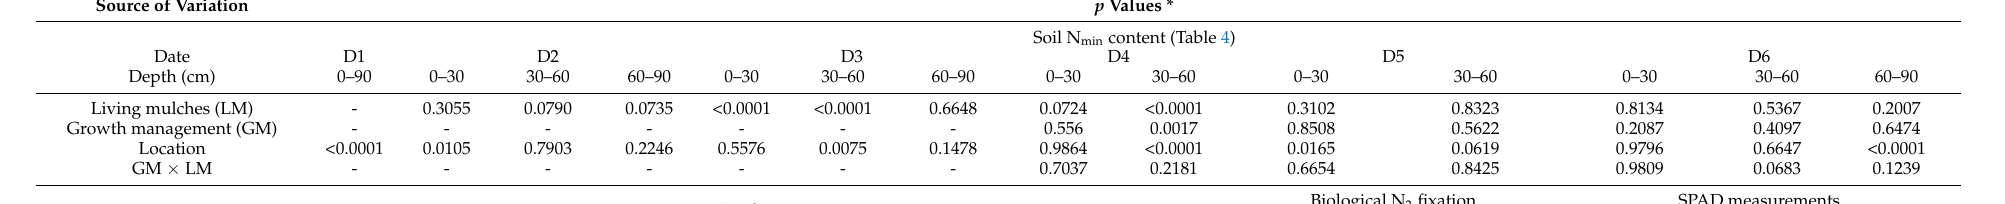
Table 3. Overview of the sources of variations and p values which correspond to global F tests from the analysis of variance. Source of